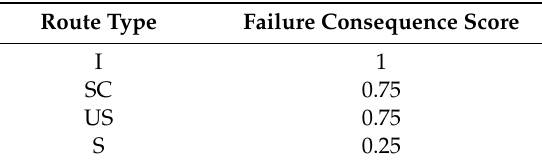
Table 9. Failure consequence scores.